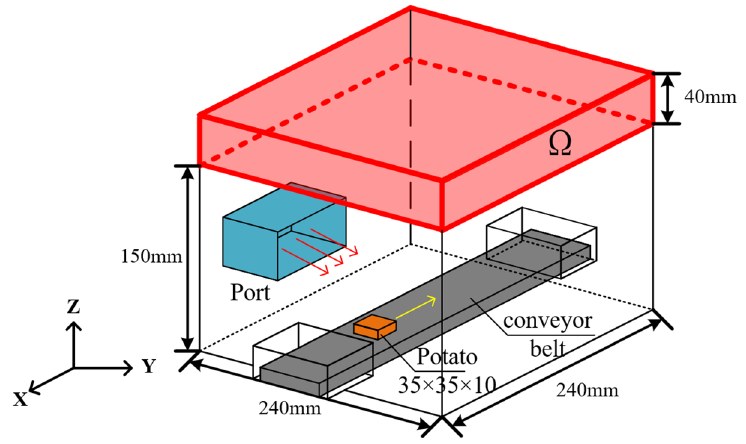
Figure 1. Structure of the simulation model. (Unit: mm).